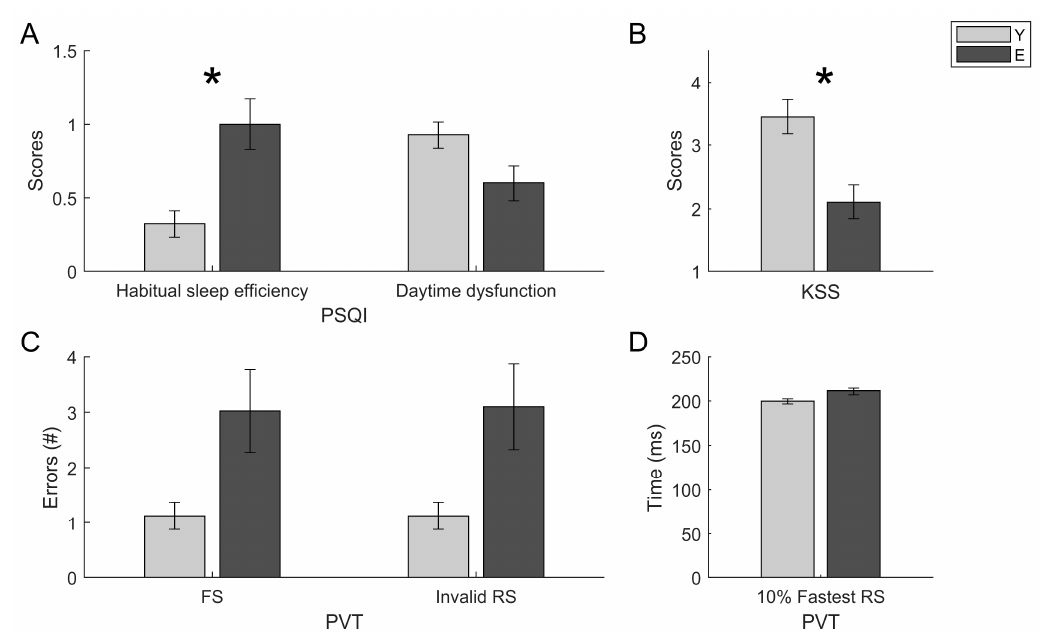
Figure 2. Results on measures of sleep quality and sleepiness. Means and standard errors of sleep quality (PSQI) ( A ), sleepiness (KSS) ( B ) and vigilance (PVT) measures ( C ), ( D ). For all graphs, asterisks denote significant differences.